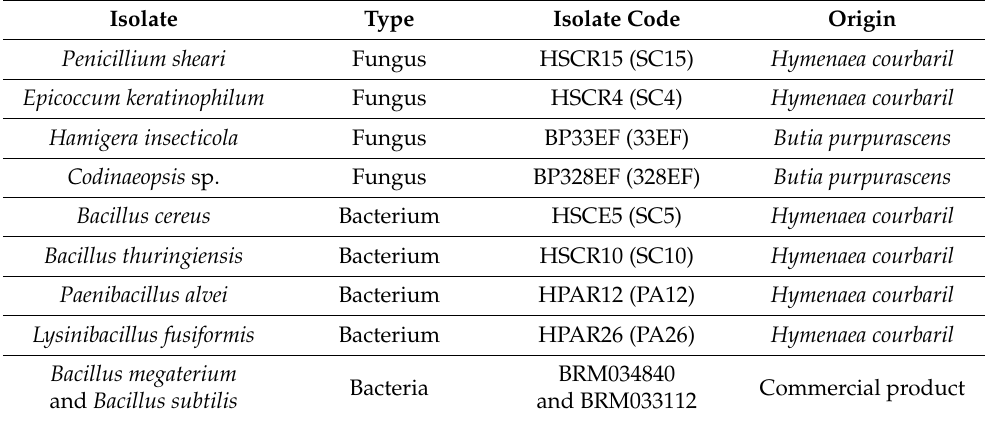
Table 1. Microbial isolates evaluated in the promotion of Glycine max growth in a controlled green- house system. In isolate code, E = endophytic; R = rhizospheric. Isolate Type Isolate Code Origin Penicillium sheari Fungus HSCR15 (SC15) Epicoccum keratinophilum Fungus HSCR4 (SC4) Hamigera insecticola Fungus BP33EF (33EF) Butia purpurascens Codinaeopsis sp. Fungus BP328EF